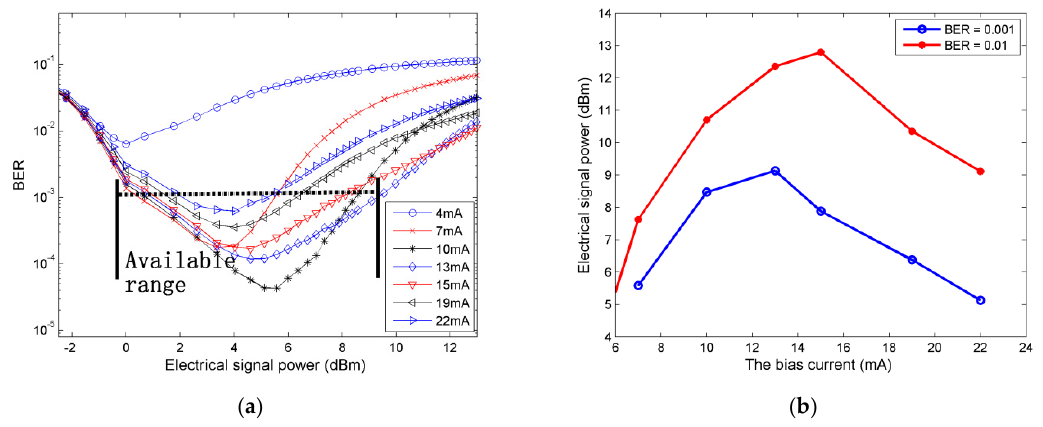
Figure 10. ( a ) BER performance at different average DMT powers ( b ) the electrical signal power for different bias currents.